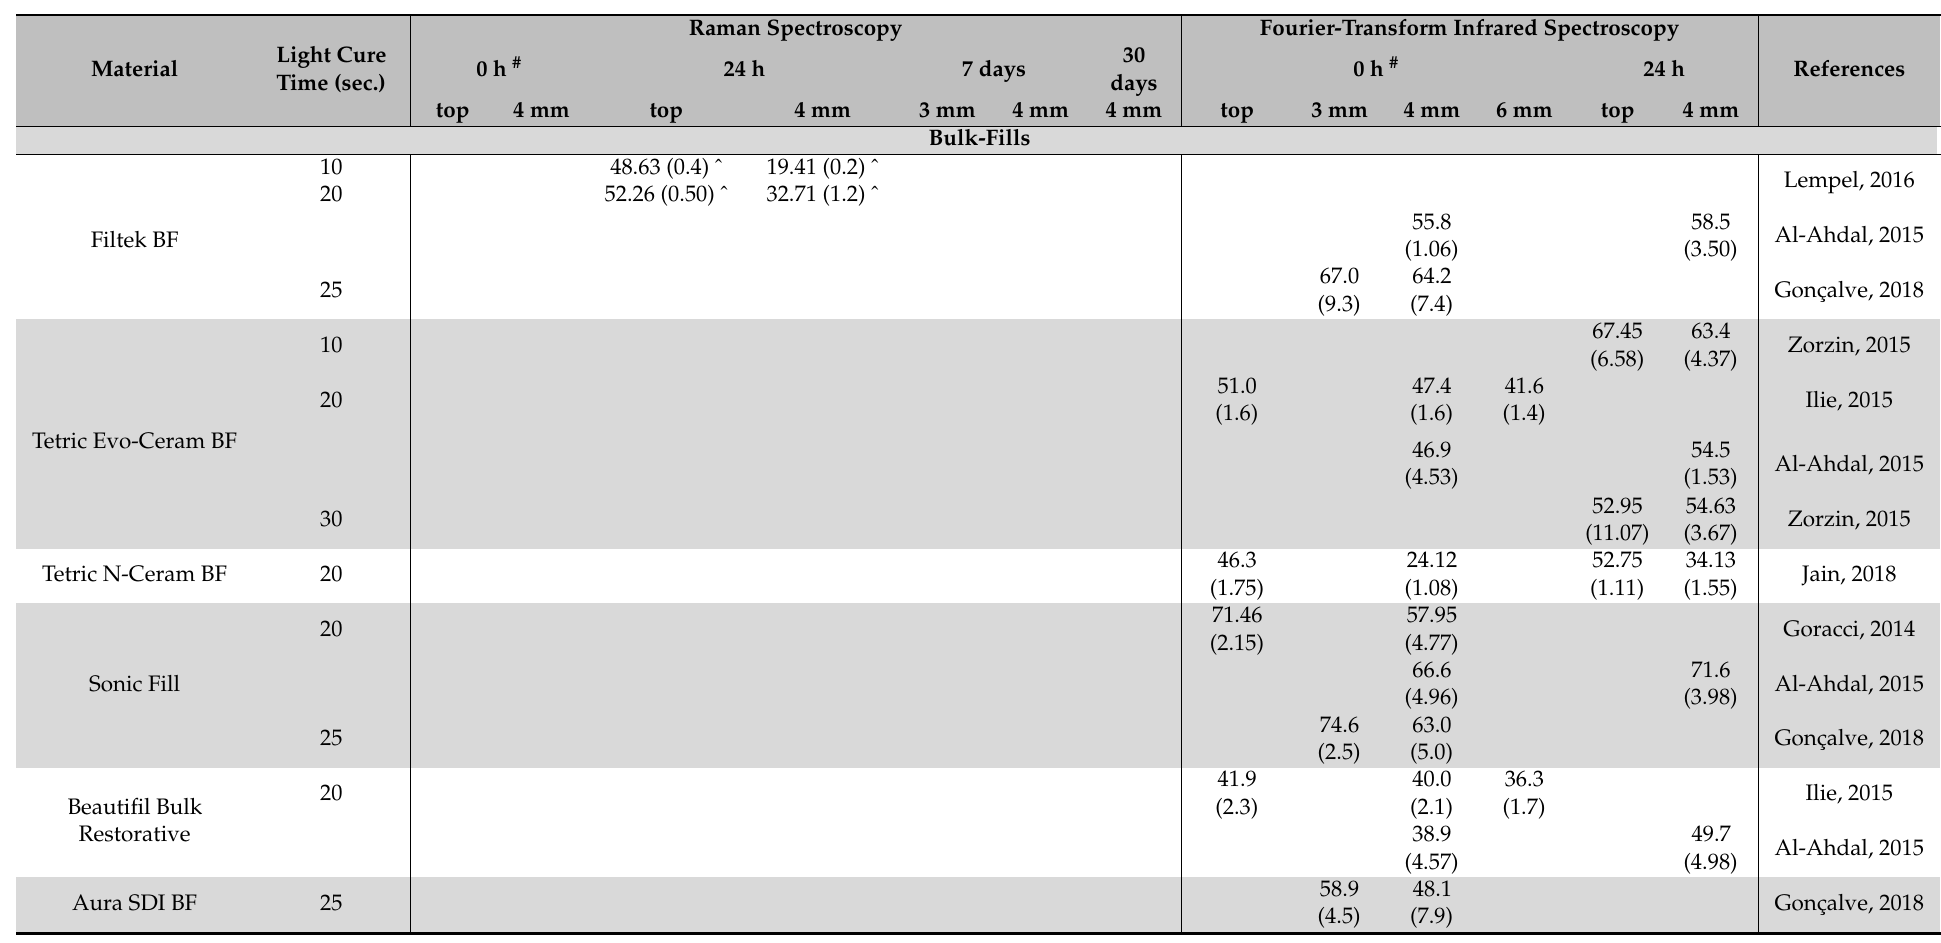
Table 3. Means and standard deviations (in parenthesis) of degree of conversion data depicted from direct